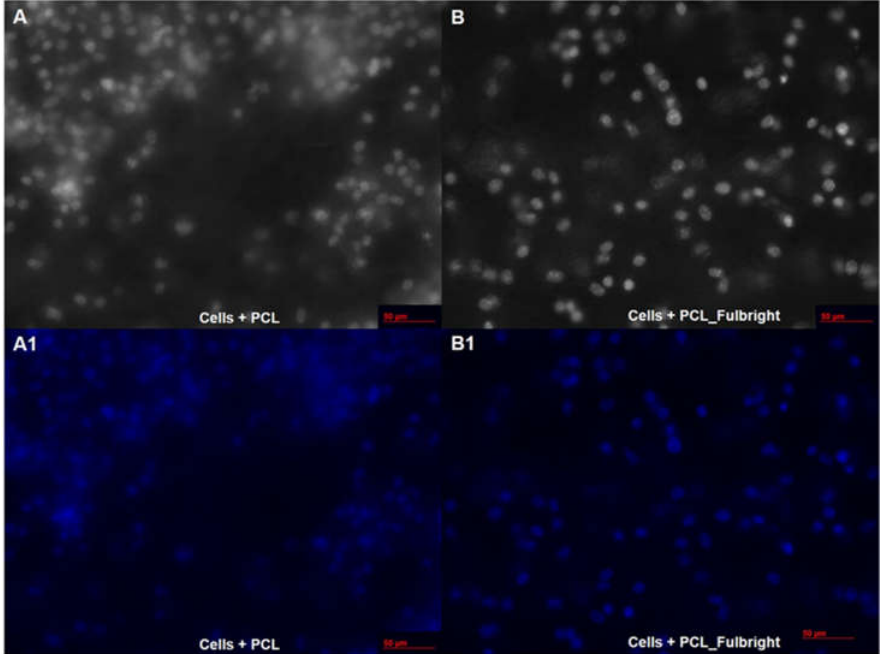
Figure 8. Fluorescent microscopy image of PCL dressing with mouse fibroblasts on top of the wound dressing in black and white ( A ) with DAPI filter ( A1 ). ( B , B1 ) represent cells on top of the phage incorporated PCL_Fulbright wound dressing.